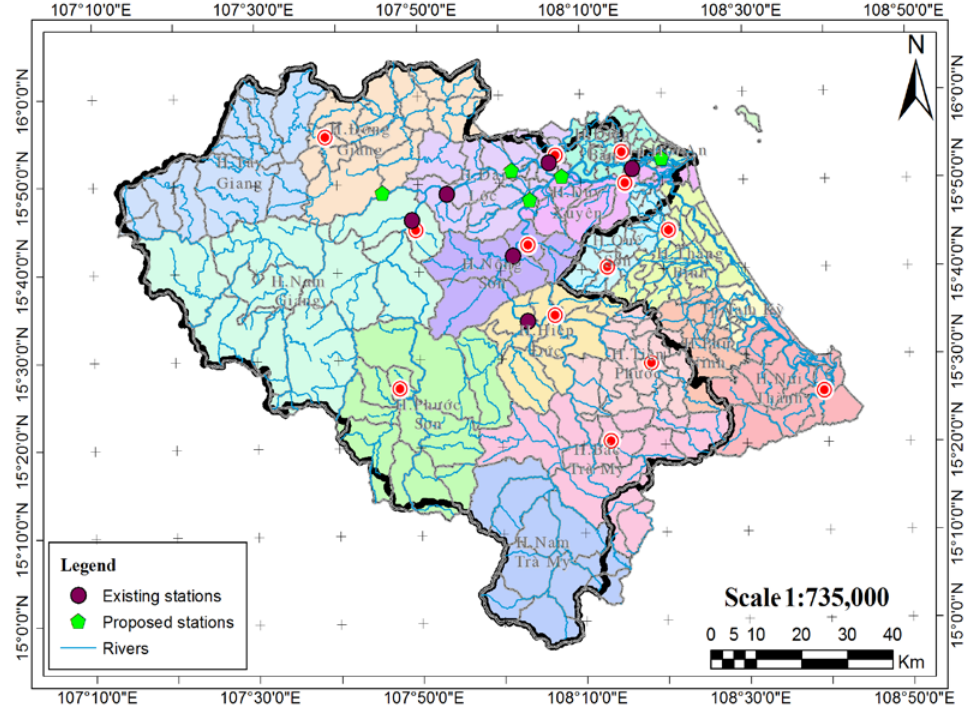
Figure 4. Location of hydrological stations on the Vu Gia-Thu Bon river basin [22] (reproduced with permission from Nguyen Thi Hong, Phan Thi Thanh Truc, Nguyen Duy Liem, and Nguyen Kim Loi, International Journal on Advanced Science Engineering Information Technology; published by Indonesian Society for Knowledge and Human Development, 2016).